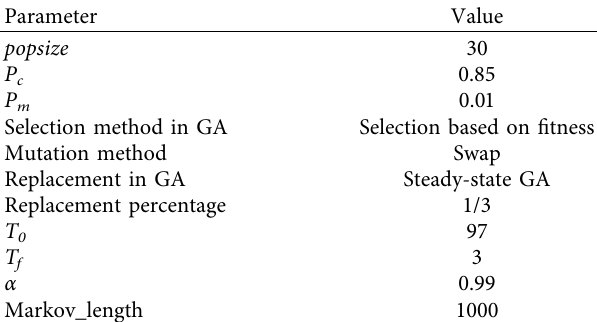
Table 5: Parameter configuration of